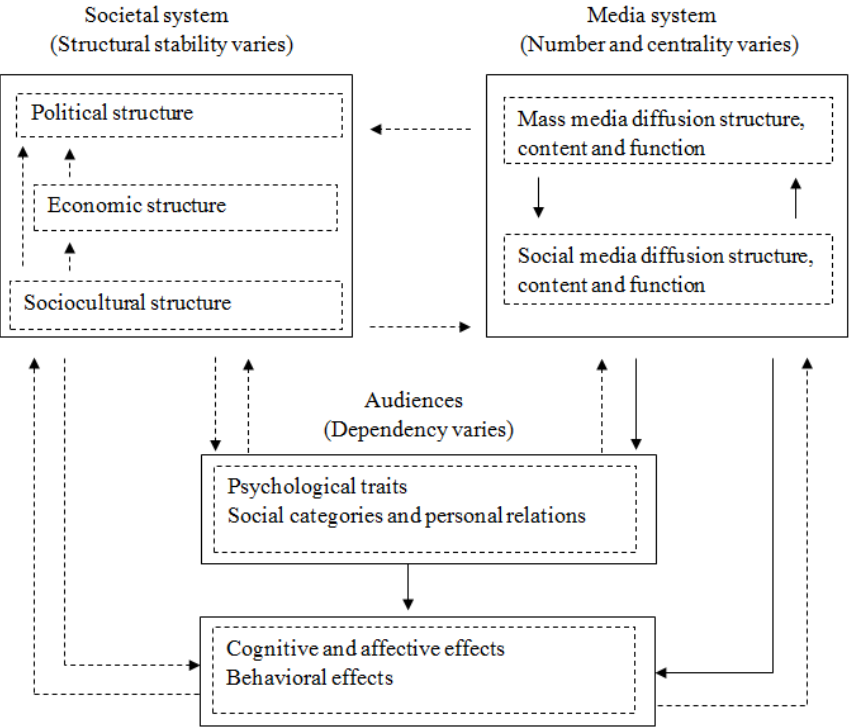
Figure 1. Proposed media system dependency personalization and political participation framework [2,4]. Notes: Solid arrows indicate relationships examined in this study; dashed arrows indicate mechanisms that contextualize proposed linkages, but were not directly measured.